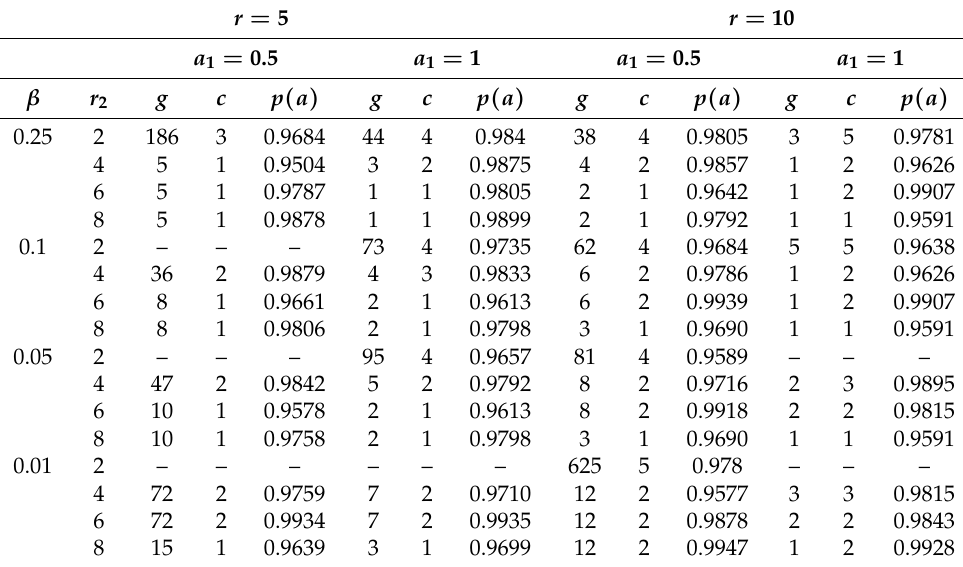
Table 5. GASP under CBellW model, ˆ β = 0.6734 and ˆ λ = 1.6316.